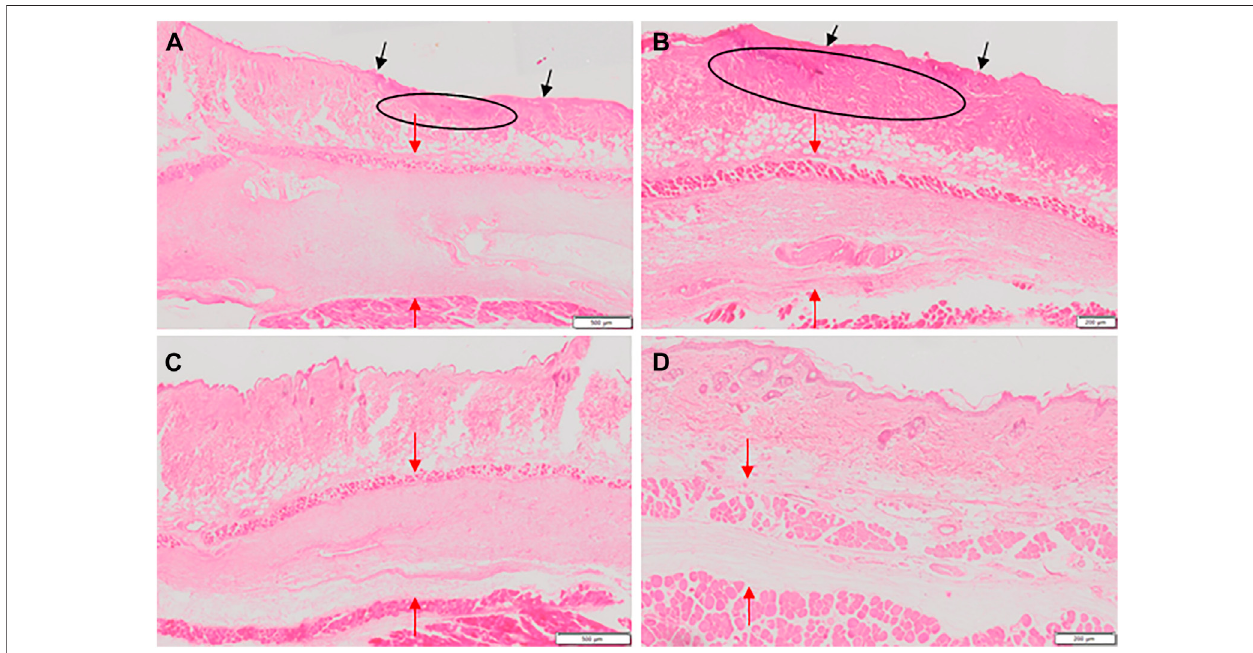
FIGURE 4 | Images of H&E stained sections of affected skin area at day fi ve of treatment with (A) trabectedin, (B) trabectedin and hyaluronidase, (C) trabectedin and tacrolimus, (D) trabectedin and DMSO. Histological sections in A and B show a loss of epidermal continuity (black arrows in A and B) and a replacement of the physiologicstructureofthedermisbythegranulationtissue(ellipse),morepronouncedinBthaninA.Duetotheedematouschanges,theconnectivetissuewasseverely loosened (red arrows) in A, B, C and D.